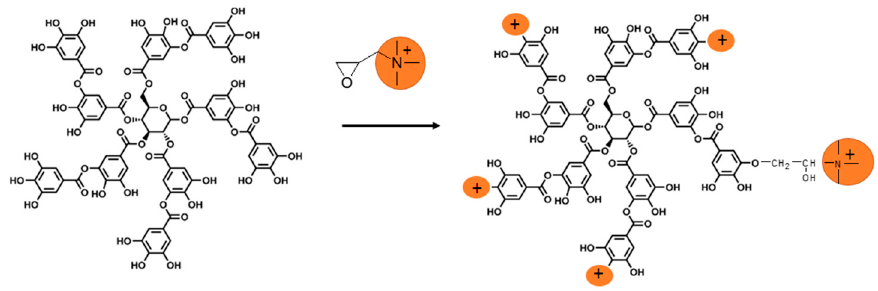
Figure 3. Schematic representation of TA-N(CH 3 ) 3+ by chemical modification of tannic acid in the presence of GTMA.